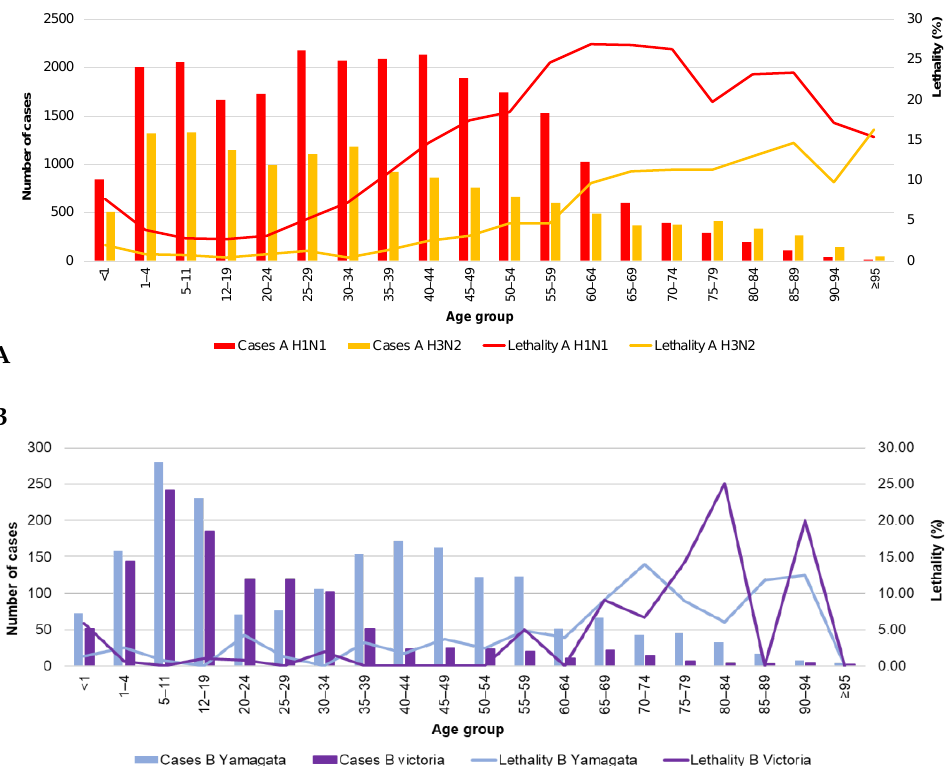
Figure 2. Cases and lethality by age group (2009–2018) and virus type. ( A ) influenza A; ( B ) influenza B. The data used in this figure were obtained from Mexico’s influenza surveillance system, SISVEFLU.